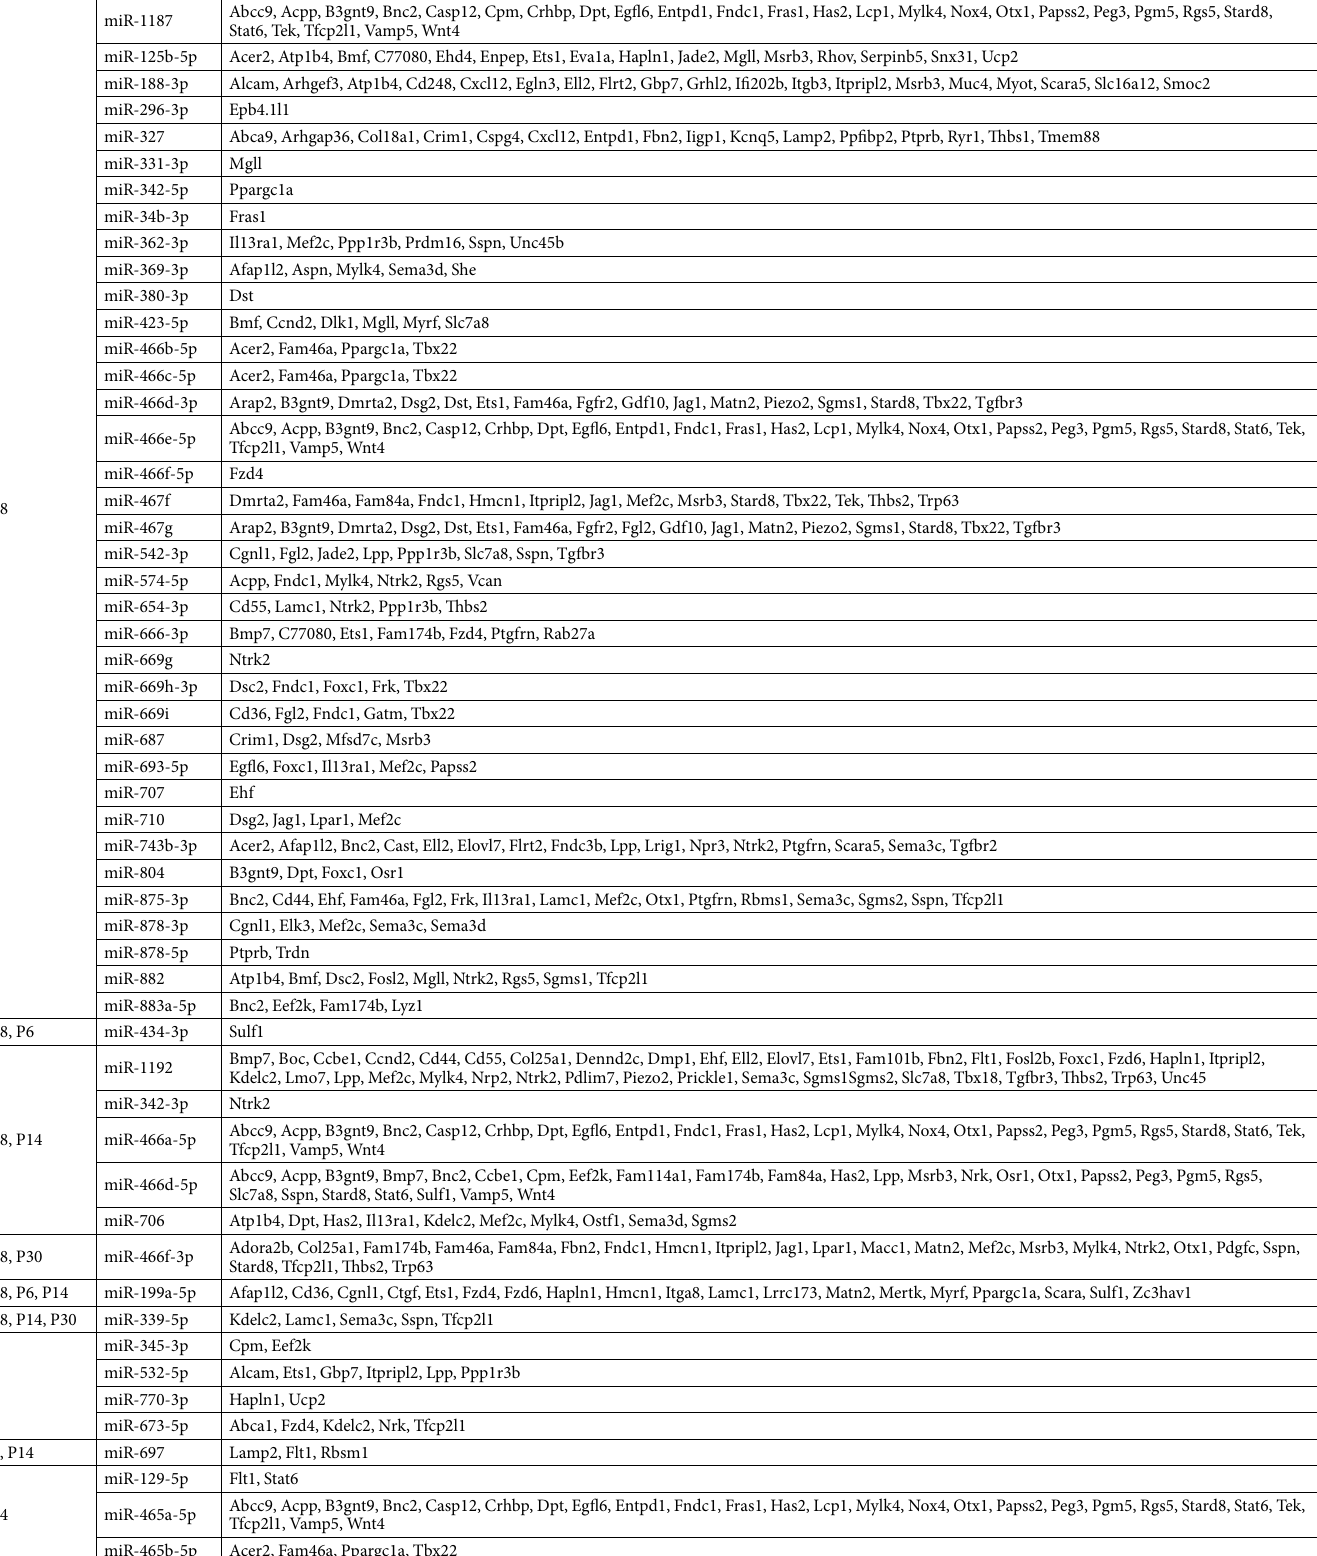
Table 1. miRNAs differentially expressed in rd7 vs B6 and their potential target genes. Genes identified through microarray data of differentially expressed genes in rd7 vs B6. Minimum 2 fold change and p <